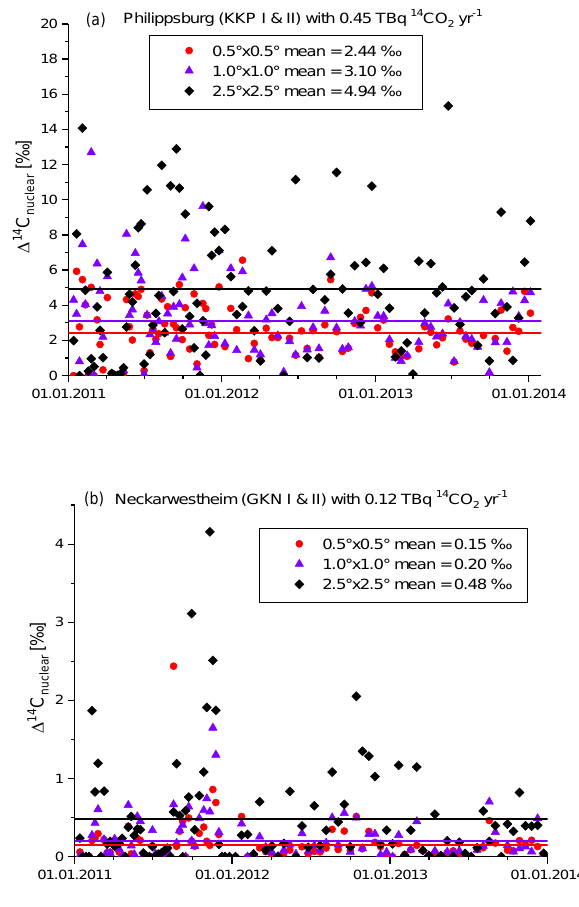
Figure 4. (a) Calculated (cid:49) 14 C nuclear contributions from Philipps- burg with assumed constant 14 CO 2 emissions using the three wind fields with different resolution. (b) Same as (a) , showing the contri- butions from Neckarwestheim.